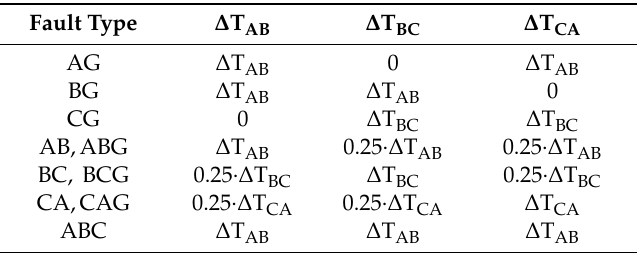
Table 1. Classical classification of di ff erent types of fault according to the values of scalar products for a synchronous grid [29].